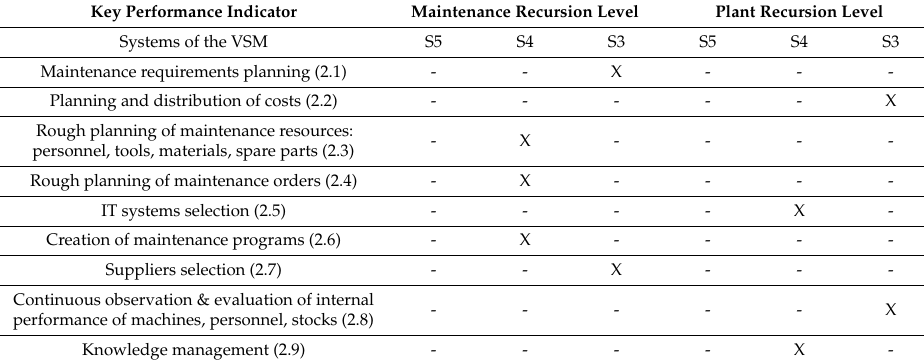
Table 2. Tactical maintenance management tasks and its classification to VSM systems (own